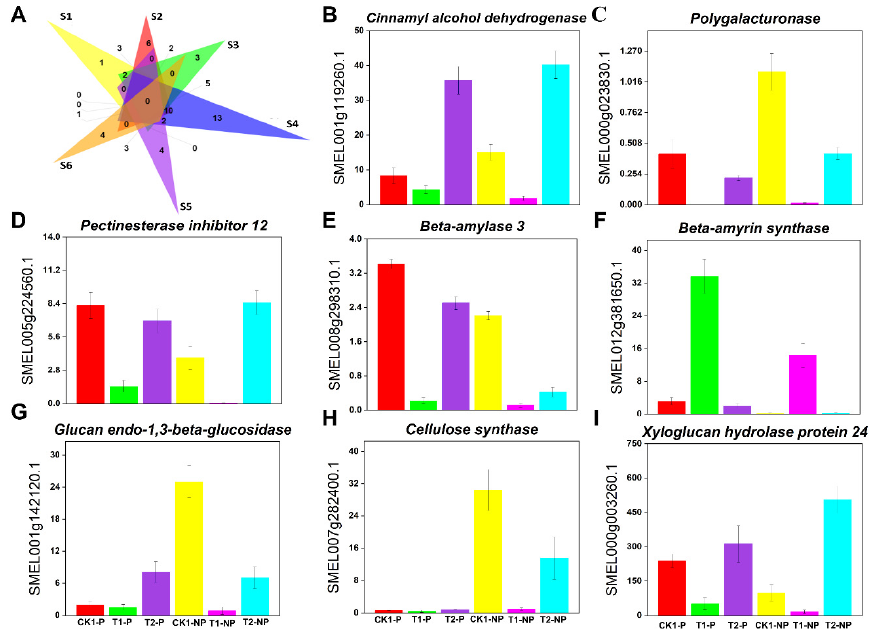
Figure 5. Effects of shading and light on gene expression and signal transduction related to eggplant peel texture. ( A ) Venn diagram showing differentially expressed genes related to eggplant peel texture in the six comparison groups (S1: CK1-P vs. T1-P; S2: T1-P vs. T2-P; S3: CK1-NP vs. T1-NP; S4: T1-NP vs. T2-NP; S5: T1-P vs. T1-NP; and S6: T2-P vs. T2-NP); ( B ) Cinnamyl alcohol dehydrogenase ( CAD ); ( C ) Polygalacturonase ( PG ); ( D ) Pectinesterase inhibitor 12 ( PME12 ); ( E ) Beta-amylase 3 ( BAM3 ); ( F ) Beta-amyrin synthase ( BAS ); ( G ) Glucan endo-1,3-beta-glucosidase ( GLUB ); ( H ) Cellulose synthase ( CES ); and ( I ) Xyloglucan hydrolase protein 24 ( XTH24 ). (( B – I ): The X-axis represents different eggplant groups, and the Y-axis represents FPKM values).